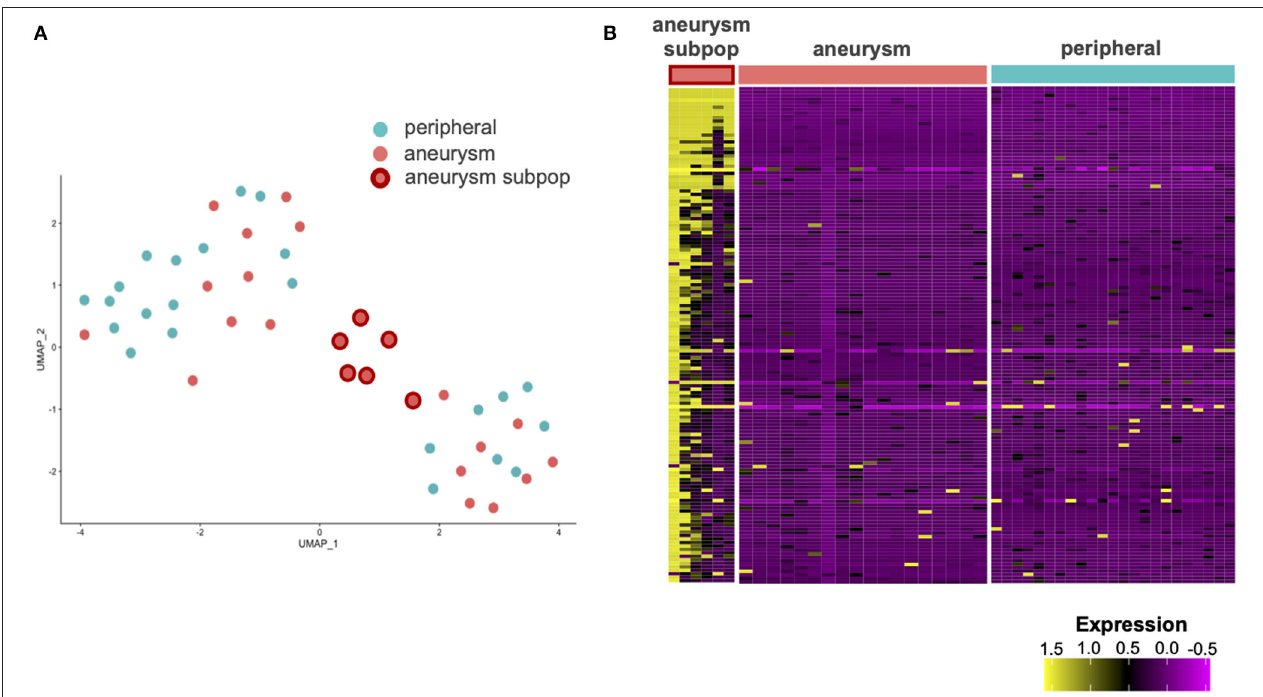
FIGURE 2 | Single cell RNA sequencing (scRNAseq) of the ECs from aneurysm and femoral artery reveals differentially expressed genes (DEGs). (A) Uniform manifold approximation and projection (UMAP) analysis of scRNAseq results demonstrates a subpopulation of aneurysmal endothelial cells (orange with red border) in altered transcriptional state relative to the other aneurysmal ECs (orange) and non-aneurysmal peripheral femoral endothelial cells (turquoise). (B) A heatmap with the columns as cells and the rows as genes contained in the first principal component. A subpopulation of aneurysmal ECs (far left) has an altered gene expression profile relative to the remaining